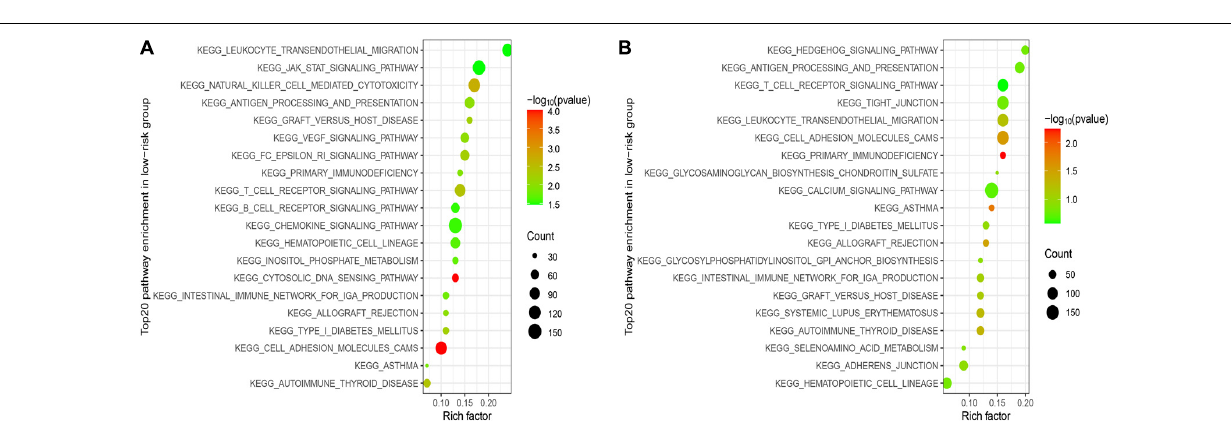
FIGURE 6 | Functional enrichment analysis between two subgroups. (A) Top 20 significantly enriched KEGG pathways in the LR group of the training cohort. (B) Top 20 significantly enriched KEGG pathways in the LR group of the validation